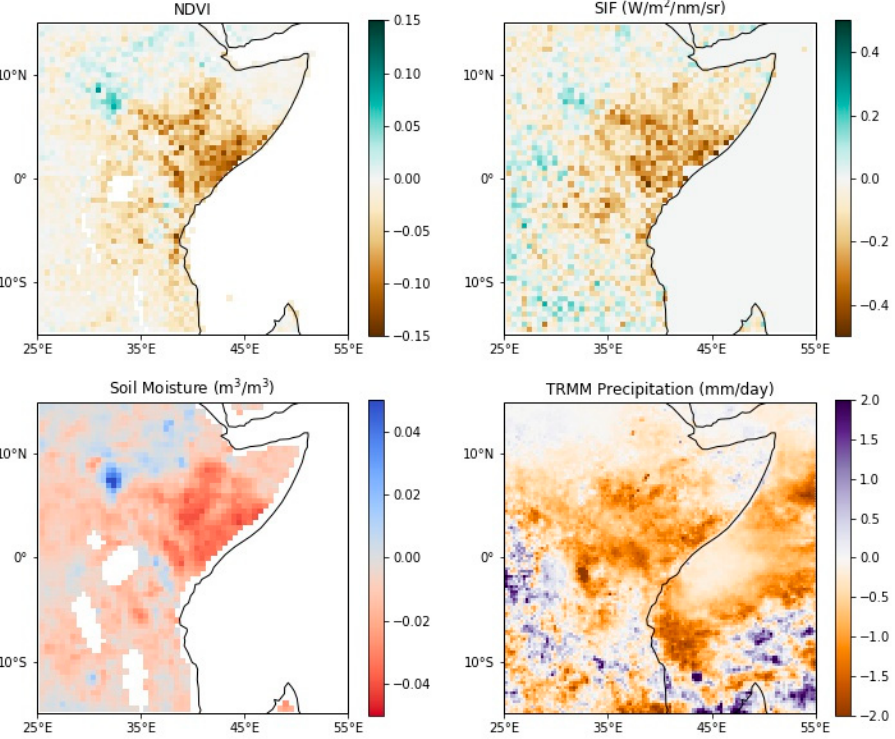
Figure 10. Anomalies of NDVI, SIF, soil moisture, and precipitation during the 2011 drought. Both SIF and NDVI approximate similar drought spatial extents. Anomalies calculated at highest available temporal resolution from the onset of the drought in October 2010 through April 2011.